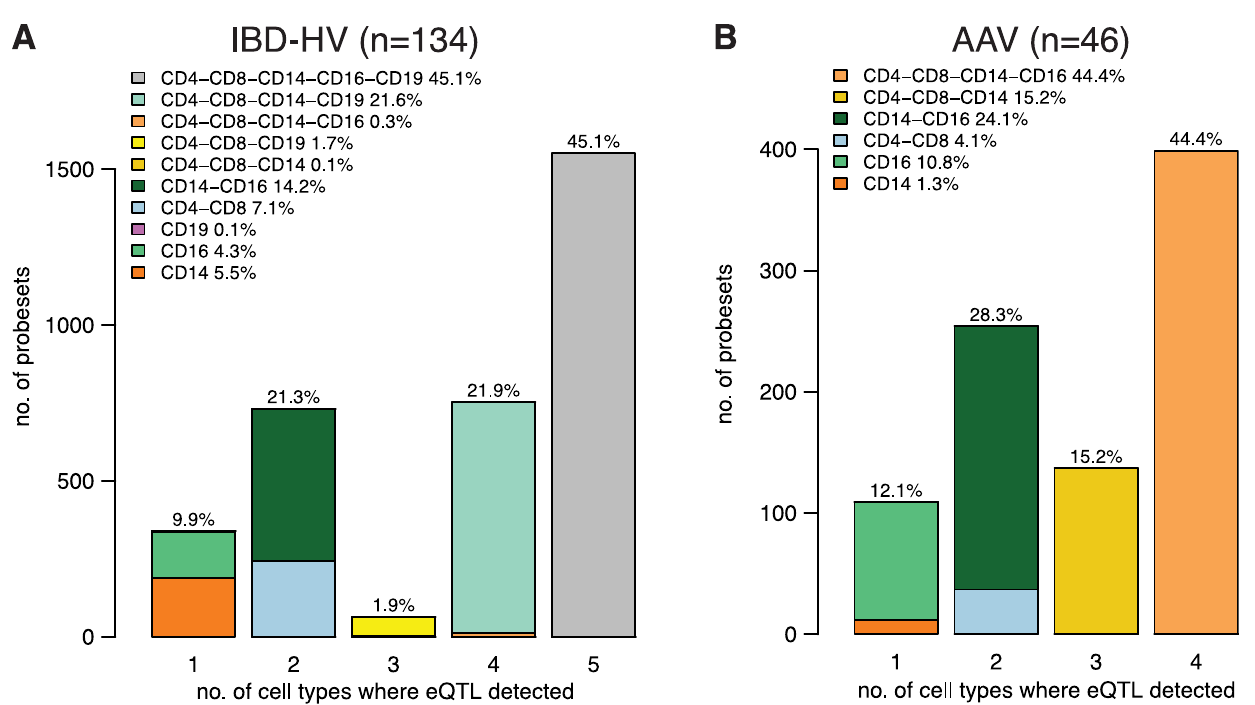
Fig 1. Estimates of eQTL sharing across leucocyte subsets from joint modelling of expression data across cell types (eQTLBMA). Number of probesets with an eQTL, subsetted according to the number of cell types in which the eQTL was declared present. Each bar is subdivided according to which cell type the eQTL was detected in. The denominator for the percentages shown is the total number of probesets for which an eQTL was detected in at least one cell type. Analysis using PEER-adjusted expression data. (A) IBD and HV analysis. (B) AAV analysis. B cell RNA was not available for a sufficient number of AAV patients for analysis. Key: CD4 = CD4 T cells, CD8 = CD8 T cells, CD14 = monocytes, CD16 = neutrophils, CD19 = B cells.